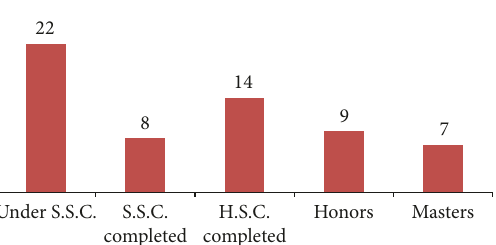
Figure 2: Distribution of misconception with educational qualifica- tion among the respondents ( 𝑛 = 60